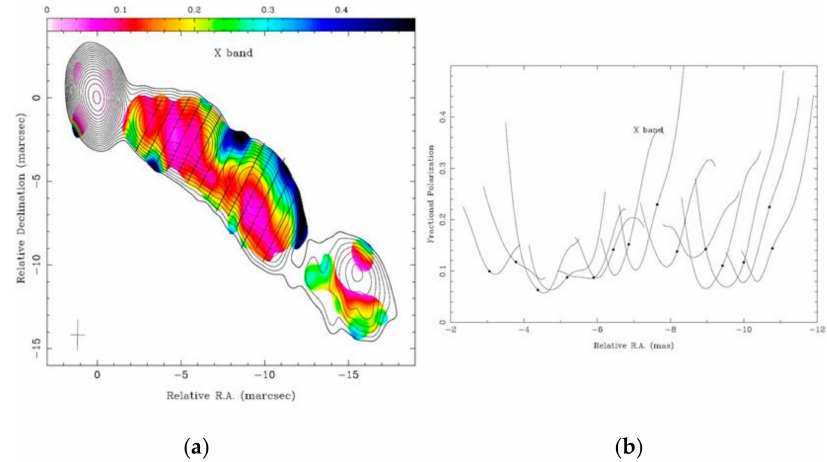
Figure 4. ( a ) Fractional polarization of the stacked images at 8 GHz. ( b ) Fourteen transverse cuts in fractional polarization. Note that the minimum in fractional polarization (red) is consistently near the center of the